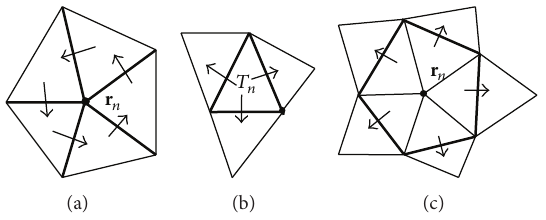
Figure 1: (a) Loop, (b) star, and (c) flower basis functions.